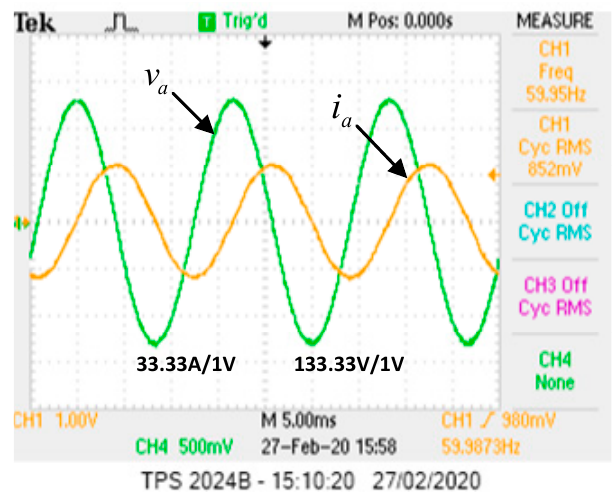
Figure 13. Steady-state of Figure 12.